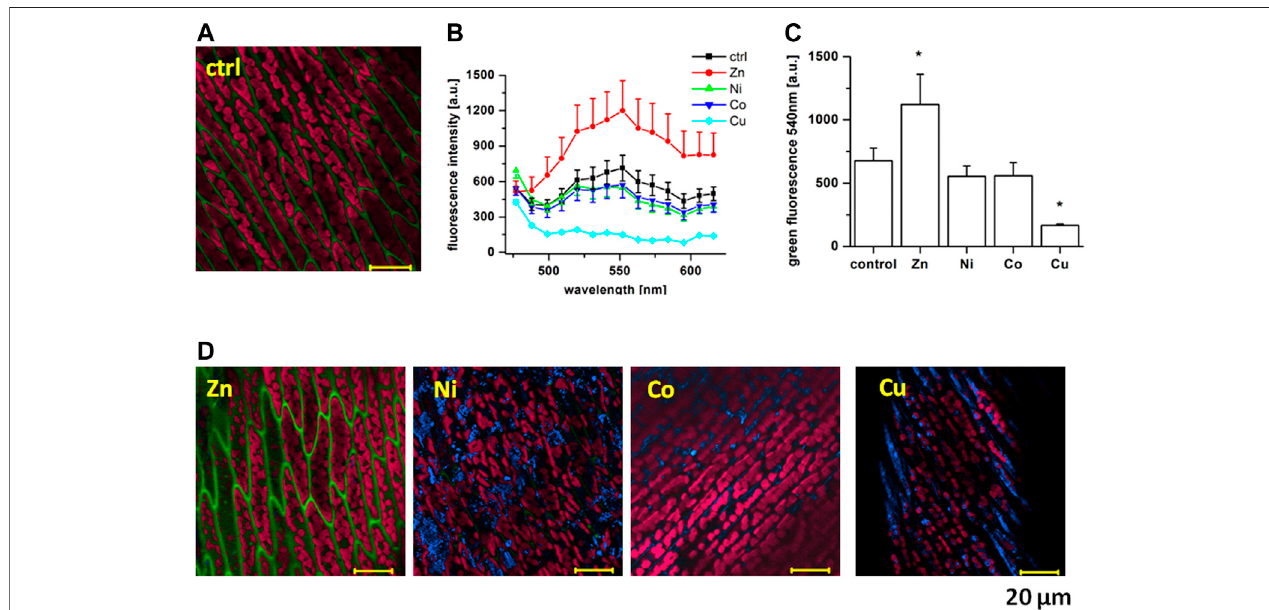
FIGURE 2 | Spectrally-resolved images of Fontinalis antipyretica blue/green fl uorescence. (A) An original lambda-coded image in control conditions taken with an 11 nmstepbetween477and638 nm,excitation 450 nm. (B) ComparisonoftherecordedspectrainthepresenceofindividualNPs( n (cid:2) 28inCtrl, n (cid:2) 20inZn, n (cid:2) 30in Ni, n (cid:2) 28 in Co, n (cid:2) 37 in Cu). (C) Statistical comparison at 540 nm, * p < 0.05 with one-way Anova. (D) Original recordings in the presence of Zn, Ni, Co and Cu NPs, scale 20 μ m.